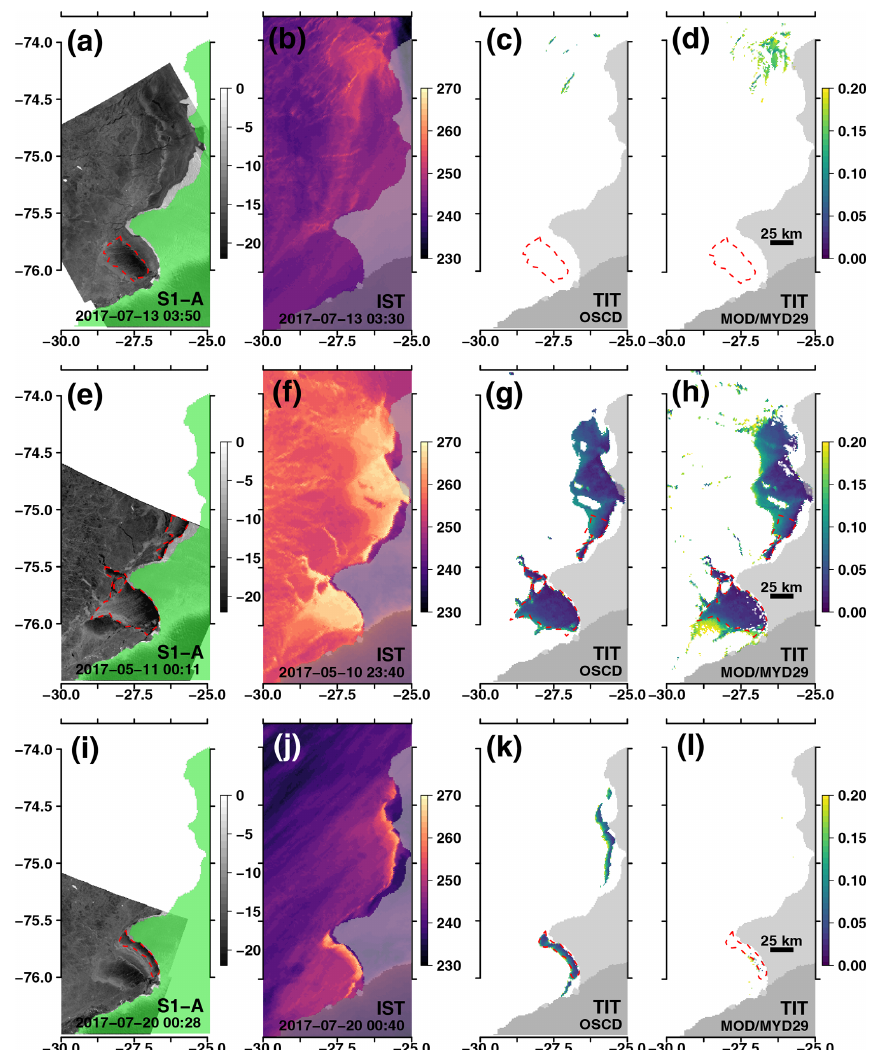
Figure 4. Compilation of exemplary co-located S1-A/B calibrated backscatter (in dB) and MODIS swaths of ice-surface temperature (IST; in K) and derived thin-ice thickness (TIT; in m) data (Table 3). Gray and green overlays highlight the ice-shelf extent. Manually picked S1-A/B reference polynya extent is outlined by a dashed red line in all panels. Please note that the date format in this figure is year month day